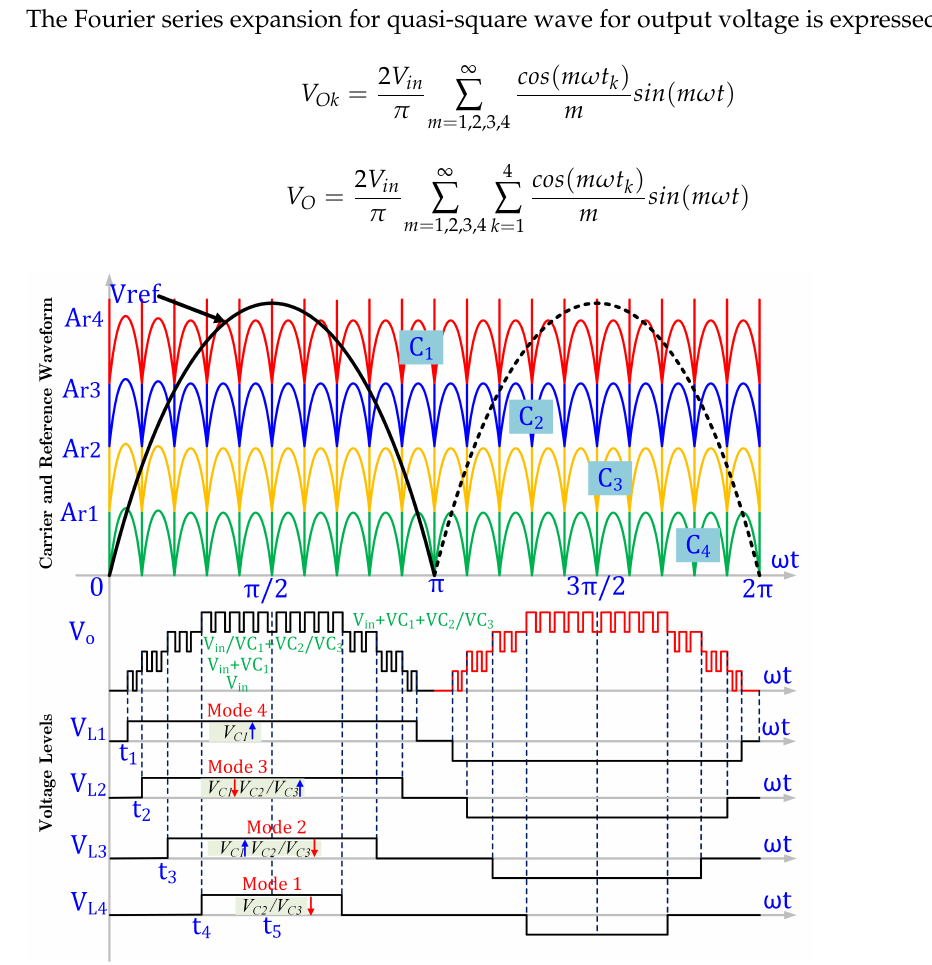
Figure 2. Parabolic carrier-based modulation scheme for